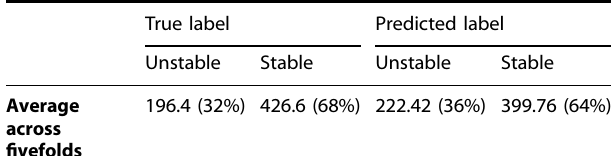
Fig. 2 Classi fi er performance. The receiver operating characteristic curve (ROC) of the random forest classi fi er across fi vefolds, comparing the ROC obtained by fi tting the dataset with synthetic data and without synthetic data. The mean area under curve (AUC) measure for the model trained on synthetic data is 0.73. Table 3. Model calibration results: A distribution comparison of the True label and the Predicted Label across fi